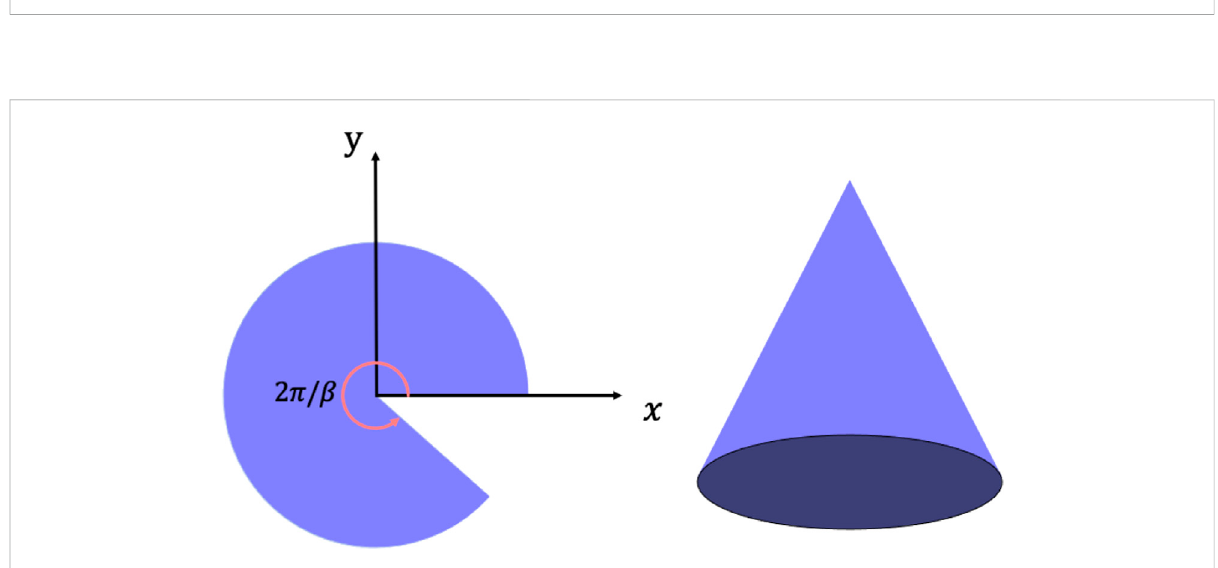
| . We choose R A = 10 l B , which is in bulk of a fi nite disk (with the 2